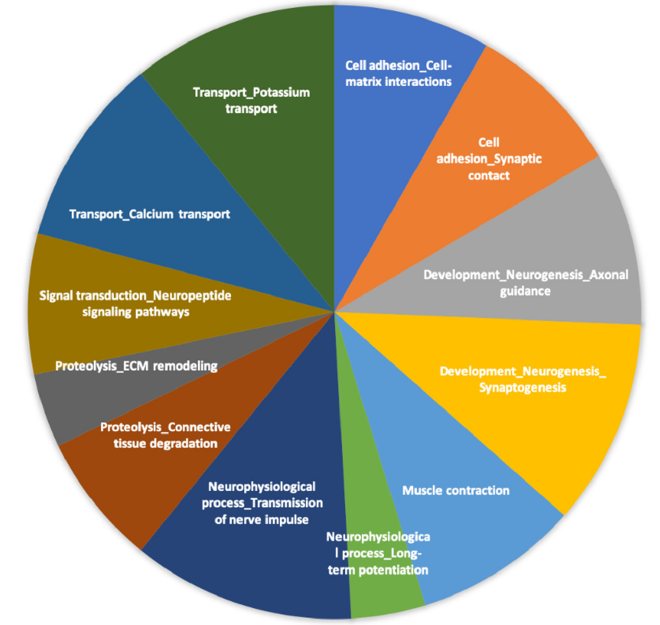
Figure 4. Networks enriched with di ff erentially expressed genes in volunteers’ peripheral blood mononuclear cells in response to Passiflora setacea pulp consumption. Gene networks were identified using MecaCore software that uses text mining approach to build gene–gene interactions and identify their cellular functions.